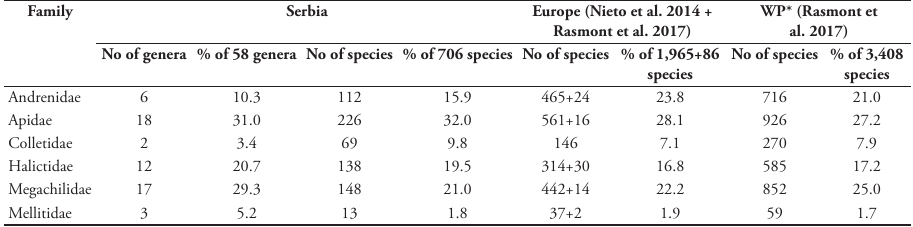
Table 1. Diversity and proportional representation of bee families in Serbia, Europe, and the West Pal- aearctic region (WP). Family